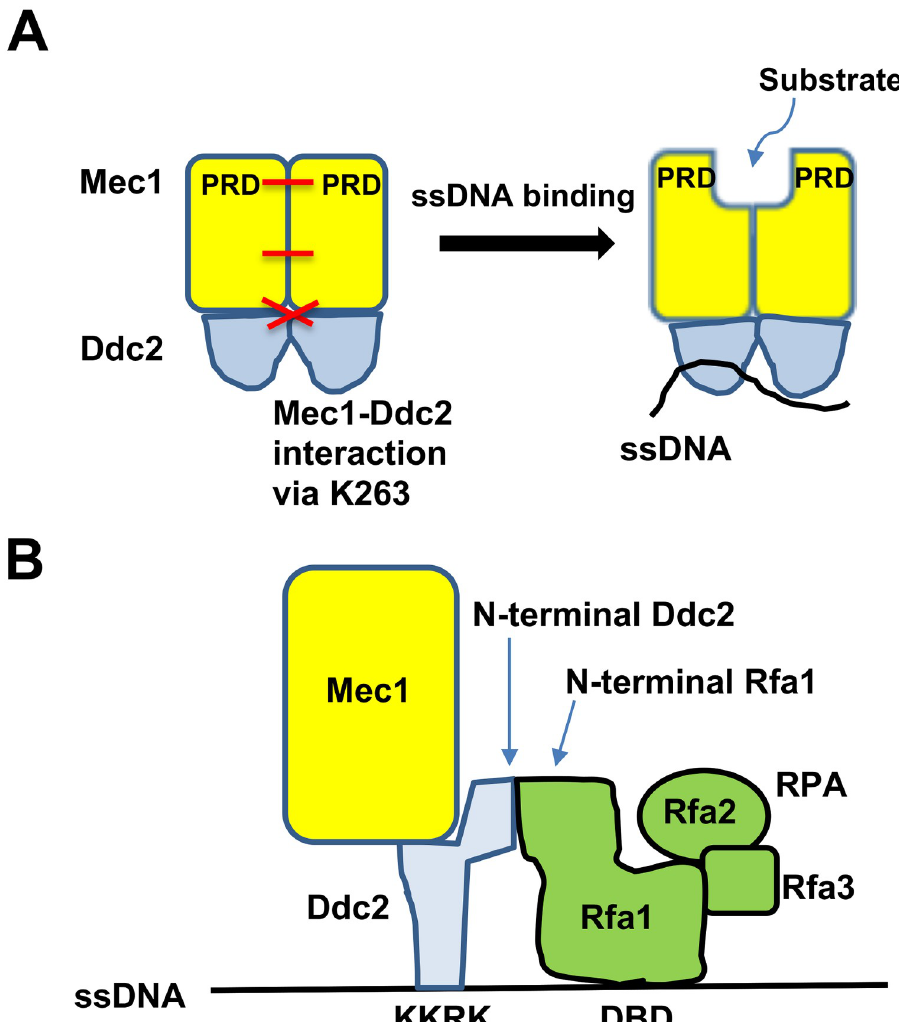
Fig 8. Model for Mec1 activation at RPA-covered ssDNA tracts. (A) ssDNA binding of Ddc2 increases Mec1 activity. ssDNA binding of Ddc2 triggers conformation changes of the entire Mec1-Ddc2 homodimer, resulting in structural changes of the kinase domain at the C-terminus of Mec1. K263 is involved in homodimerization of the Mec1-Ddc2 heterodimer. The PRD-PRD interface within the kinase domain is also involved in homodimerization of the Mec1-Ddc2 heterodimer. See text for more detail. (B) RPA promotes ssDNA-dependent Mec1 activation. The N- terminus of Ddc2 interacts with the N-terminus of Rfa1 whereas the DNA binding (KKRK) region of Ddc2 is involved in ssDNA binding. RPA alone binds to ssDNA through its own DNA binding domain (DBD). See the text for more